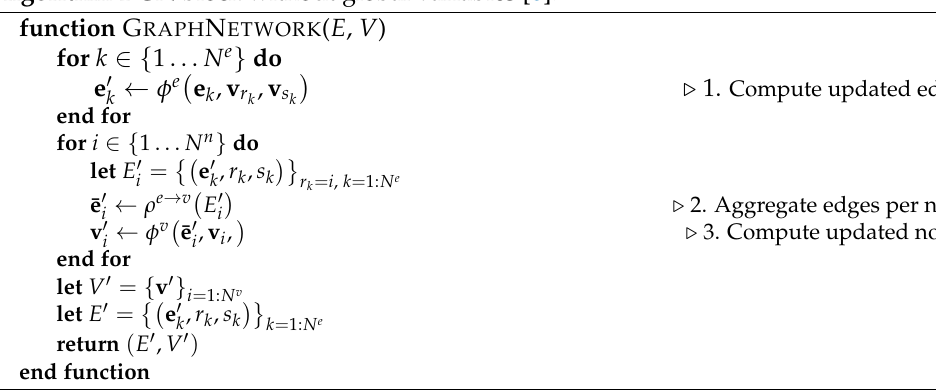
Figure 4. A single GN block with message passing. The block updates the set of edges E → E (cid:48) and nodes V → V (cid:48) according to Algorithm 1. Algorithm 1 GN block without global variables